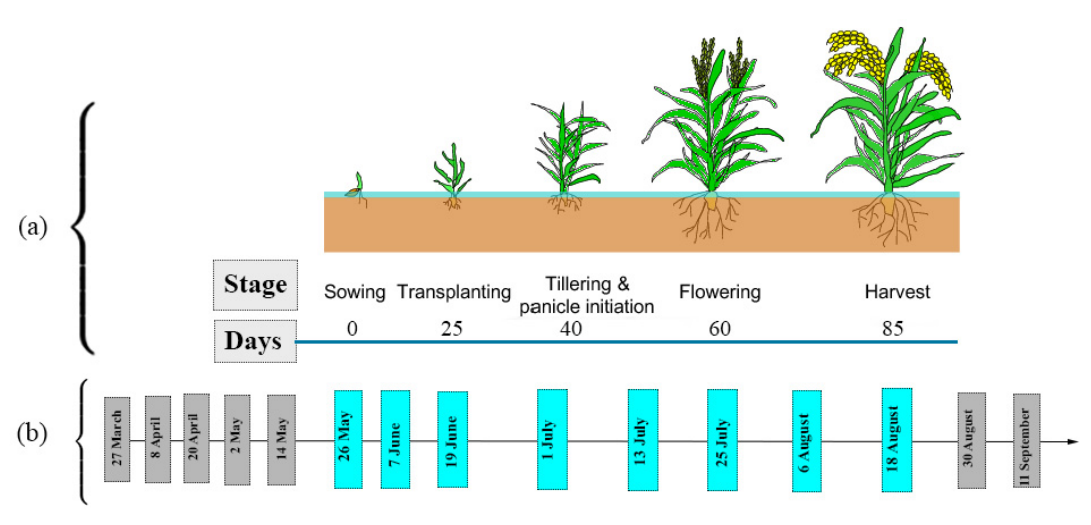
Figure 2. (a) Growth stages of rice, (b) dates for taking images.